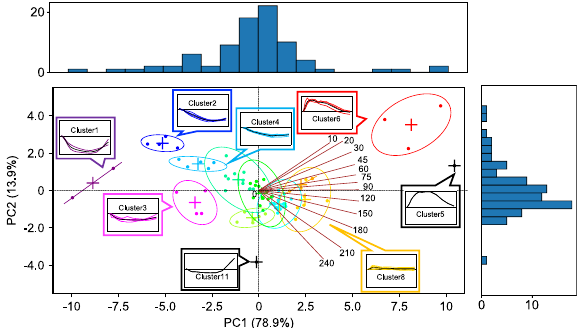
Fig. 3 Temporal pattern components of molecules. Biplot of factor loadings and scores of time courses of all molecules. The brown lines indicate factor loading and numbers indicate time points (in minutes (min)). The dots indicate the scores of the molecules. The colours of the dots and ellipses indicate the colours of the clusters classi fi ed by hierarchical clustering analysis (Fig. 2). The + symbol indicates the centre coordinates of the ellipses. The panels show average (thick line) and individual (thin line) time courses of the metabolites in a cluster. Numbers in brackets indicate the explained variance rate of each principal component (PC1 and